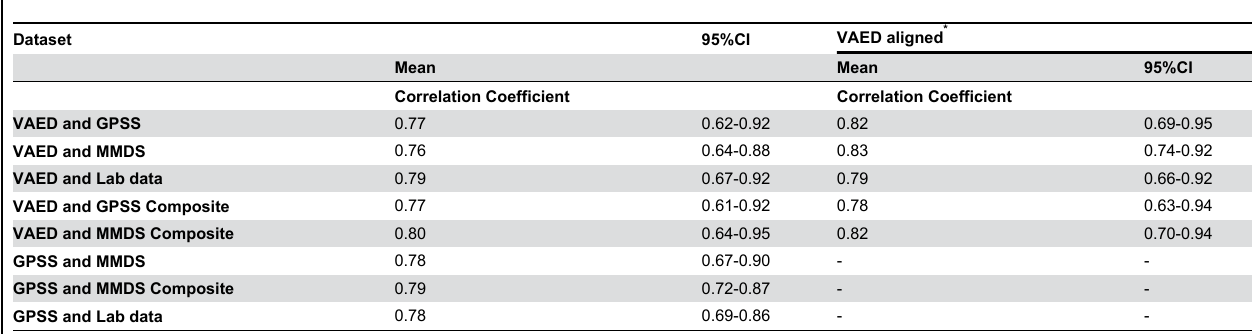
Table 3. Correlation Coefficient between different datasets,